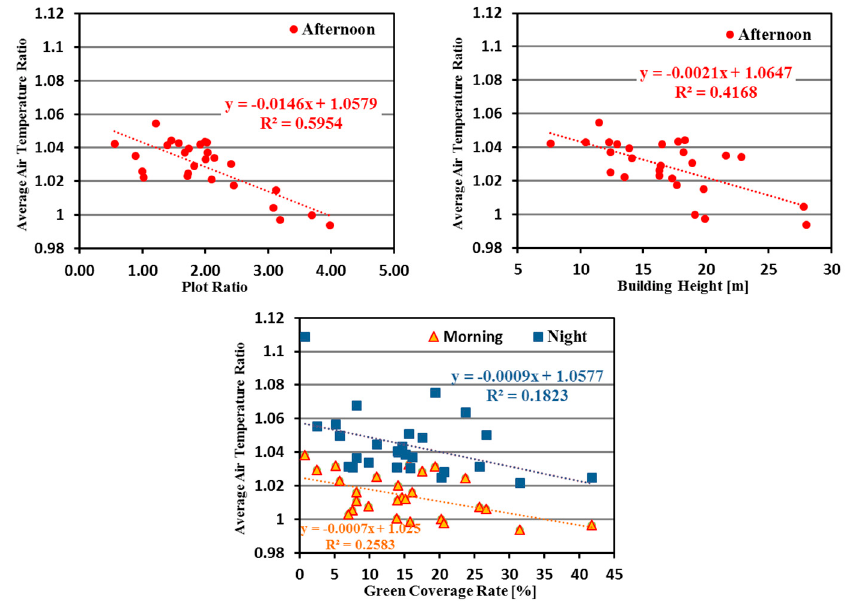
Figure 8. Relationships between Urban morphology index ( x -axis) and air temperature ratio from the mobile and reference point ( y -axis) measurements in the commercial district.